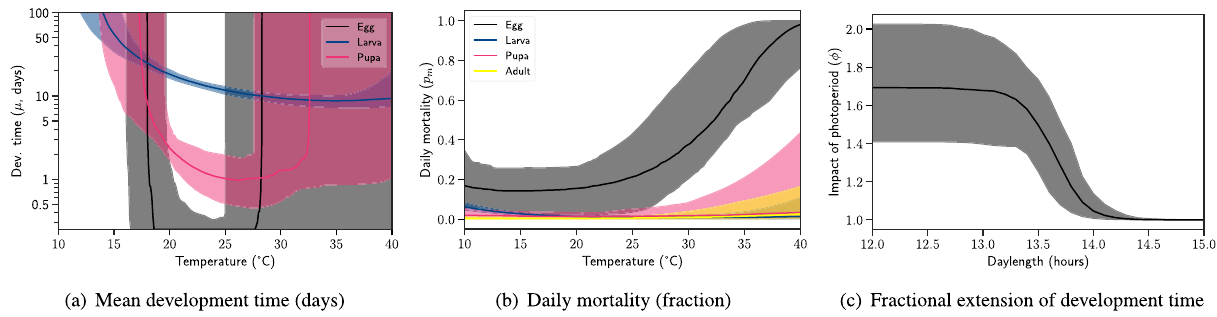
Figure 4. Environmental dependency of Cx. pipiens development and mortality inferred from semi-field life table experiments. Solid lines represent the median and shaded areas represent the 90% range.